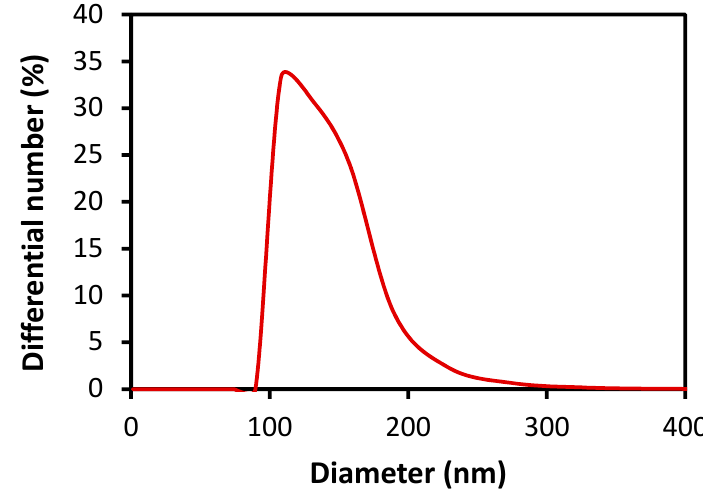
Figure 4. Size distribution of PMDA-ODA particles dispersed in distilled water (0.05 wt %) measured by dynamic light scattering (DLS).